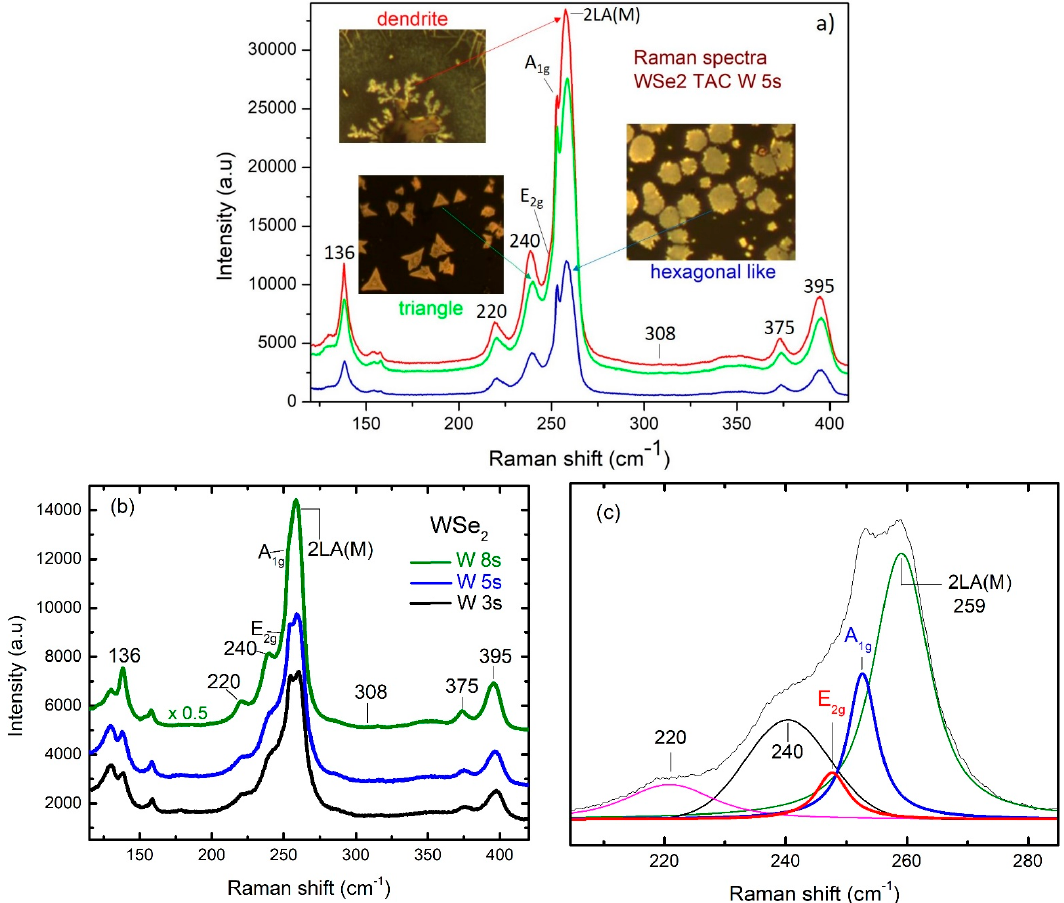
Figure 4. Raman spectra of WSe 2 flakes ( a ) different shapes and ( b ) polycrystalline WSe 2 layers with three different W deposition times as indicated in the plot ( c ) Deconvolution of the main Raman band between 200 cm − 1 and 300 cm − 1 of spectrum W 3 s (panel b ). The peaks of the Raman active modes A 1g (blue) and E 2g (red) are plotted with thicker traces.